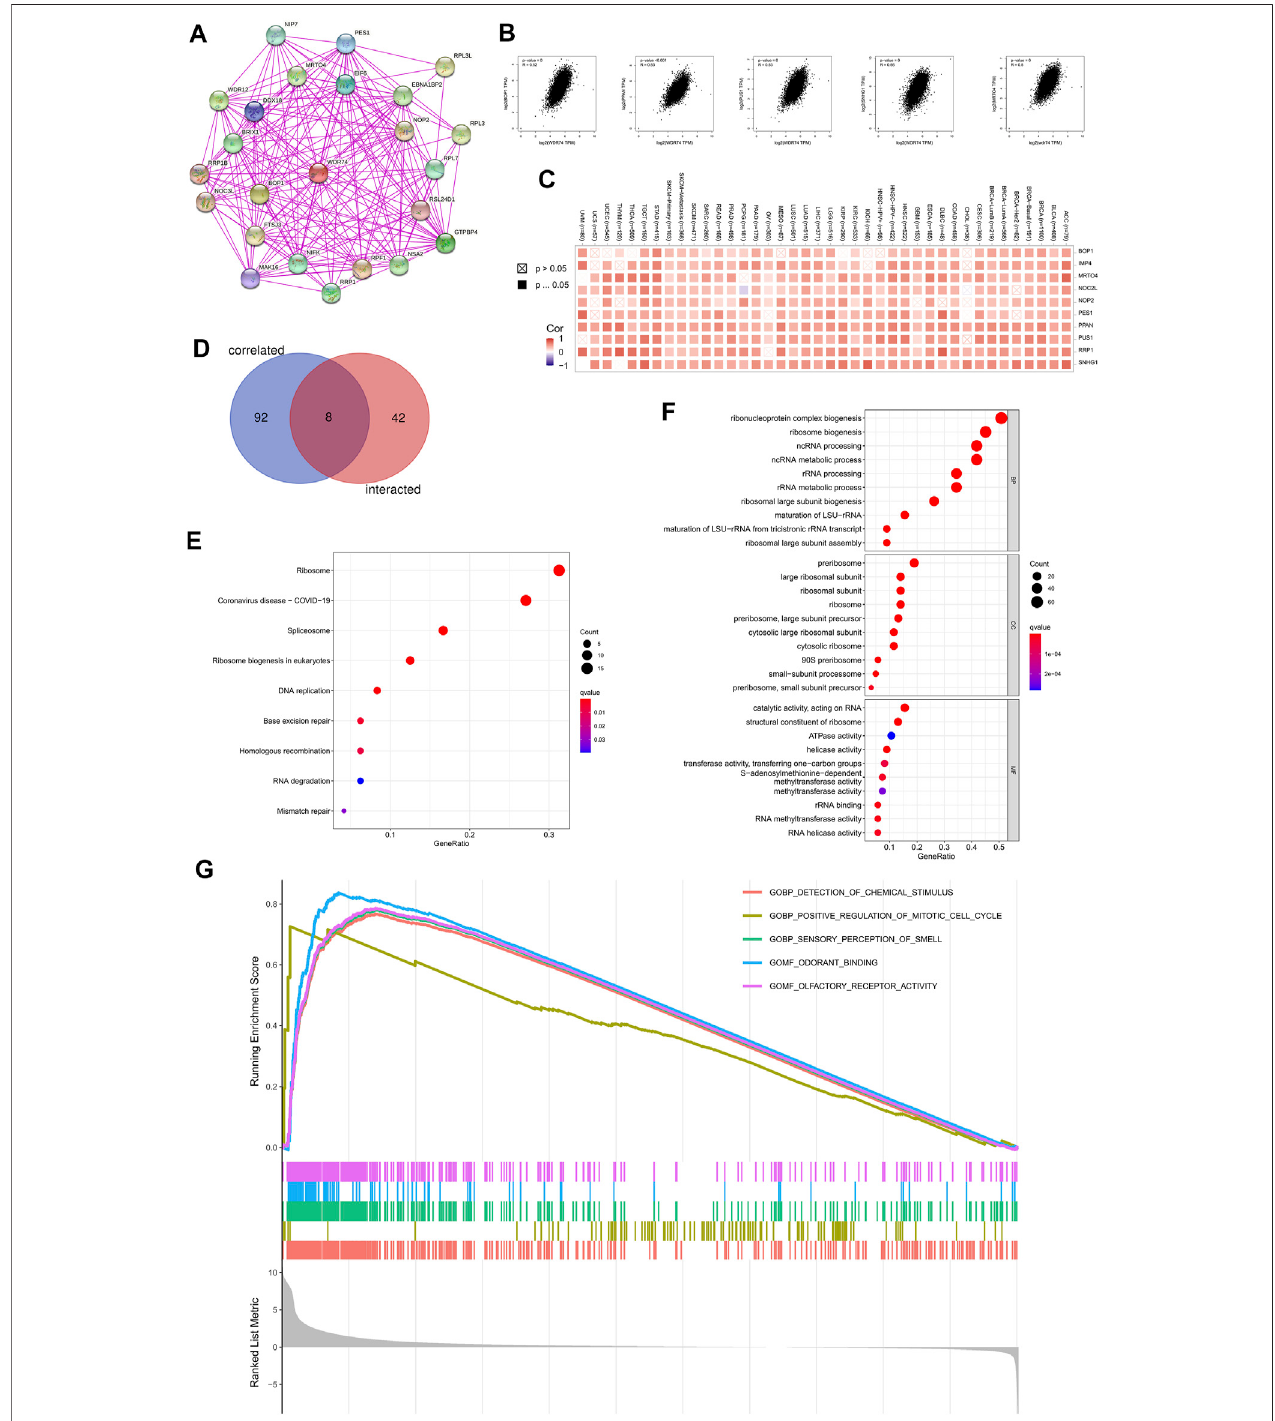
FIGURE 5 | Enrichment analysis on WDR74 were conducted to further investigate its role in tumorigenesis. We obtained WDR74-binding proteins with experimental evidence using the STRING tool (A) . Top 100 WDR74-correlated genes were selected from TCGA projects and the correlation between WDR74 expression and selected targeting genes, including BOP1, PPAN, PUS1, SNHG1, and MRTO4, was analyzed on GEPIA2 (B) . The corresponding heatmap data in the detailed cancer types are shown (C) . We conducted an intersection analysis between the selected 50 WDR74-binding genes and 100 WDR74-correlated genes (D) . We utilized WDR74-binding genes and WDR74-interacted genes to perform KEGG pathway analysis (E) . The bubble chart of GO analysis is shown (F) . Based on GSEA, GO enrichment analysis on LUSC is shown (G) .